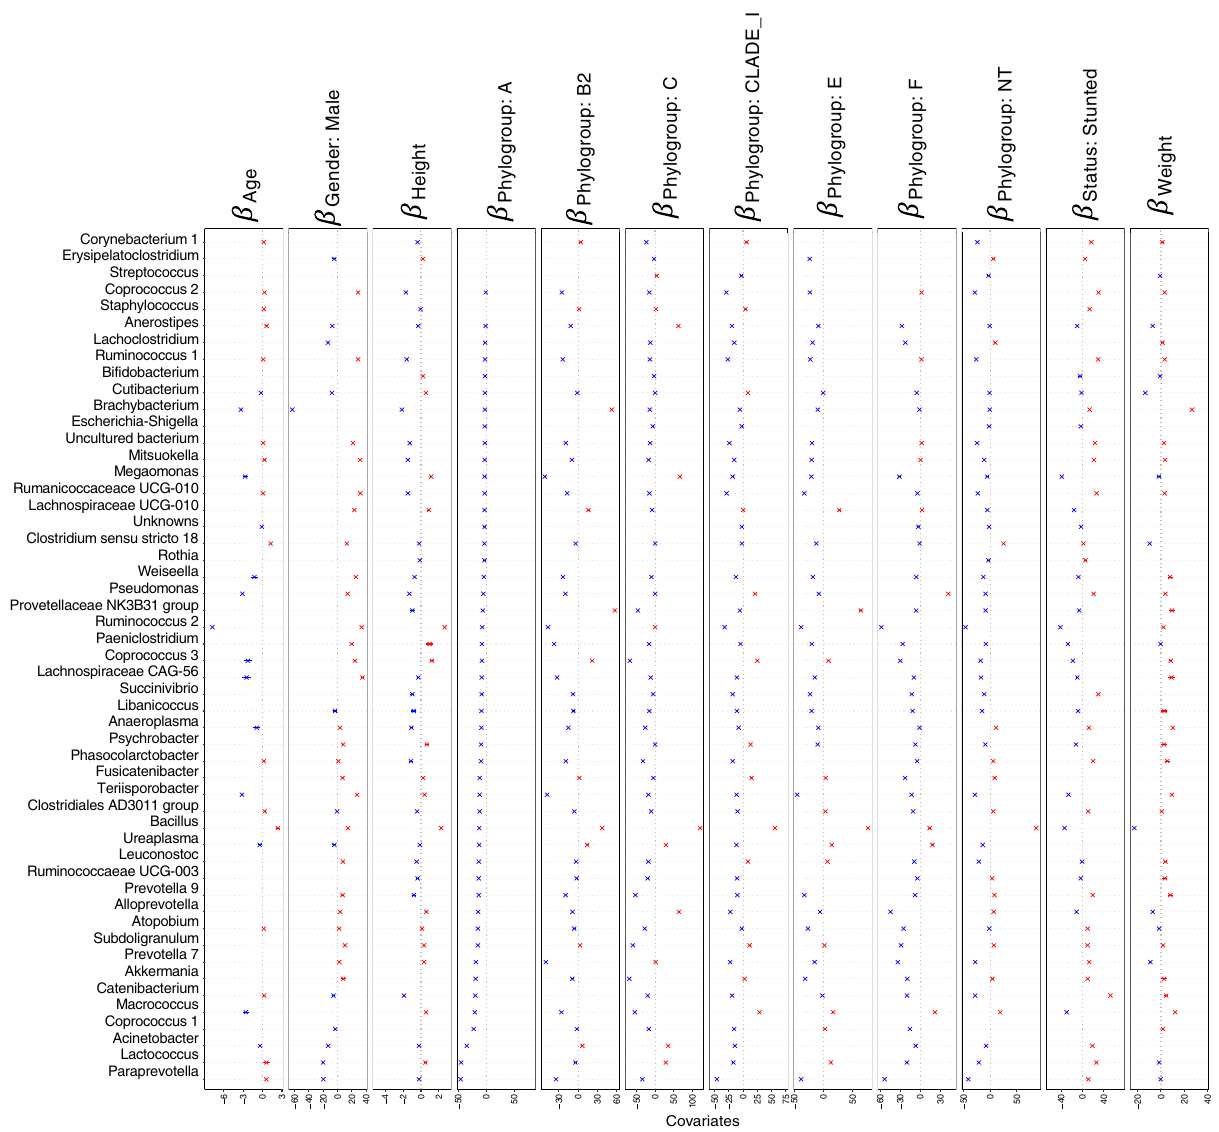
Figure 9. Continuation of Fig. 8 for the remaining beta-coefficients for 51 genera returned from the GLLVM procedure when considering phylogroups in the